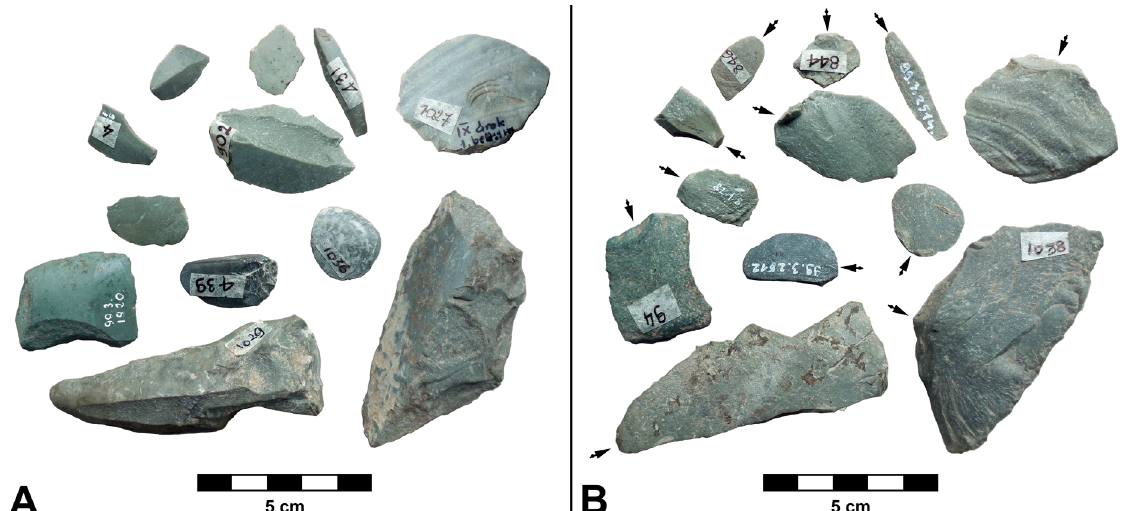
Figure 5. Hódmezővásárhely -Gorzsa, late Neolithic, Tisza Culture: knapped flakes and bladelets with bulb of percussion (black arrows), dorsal (A) and ventral (B) views, from hornfels polished stone